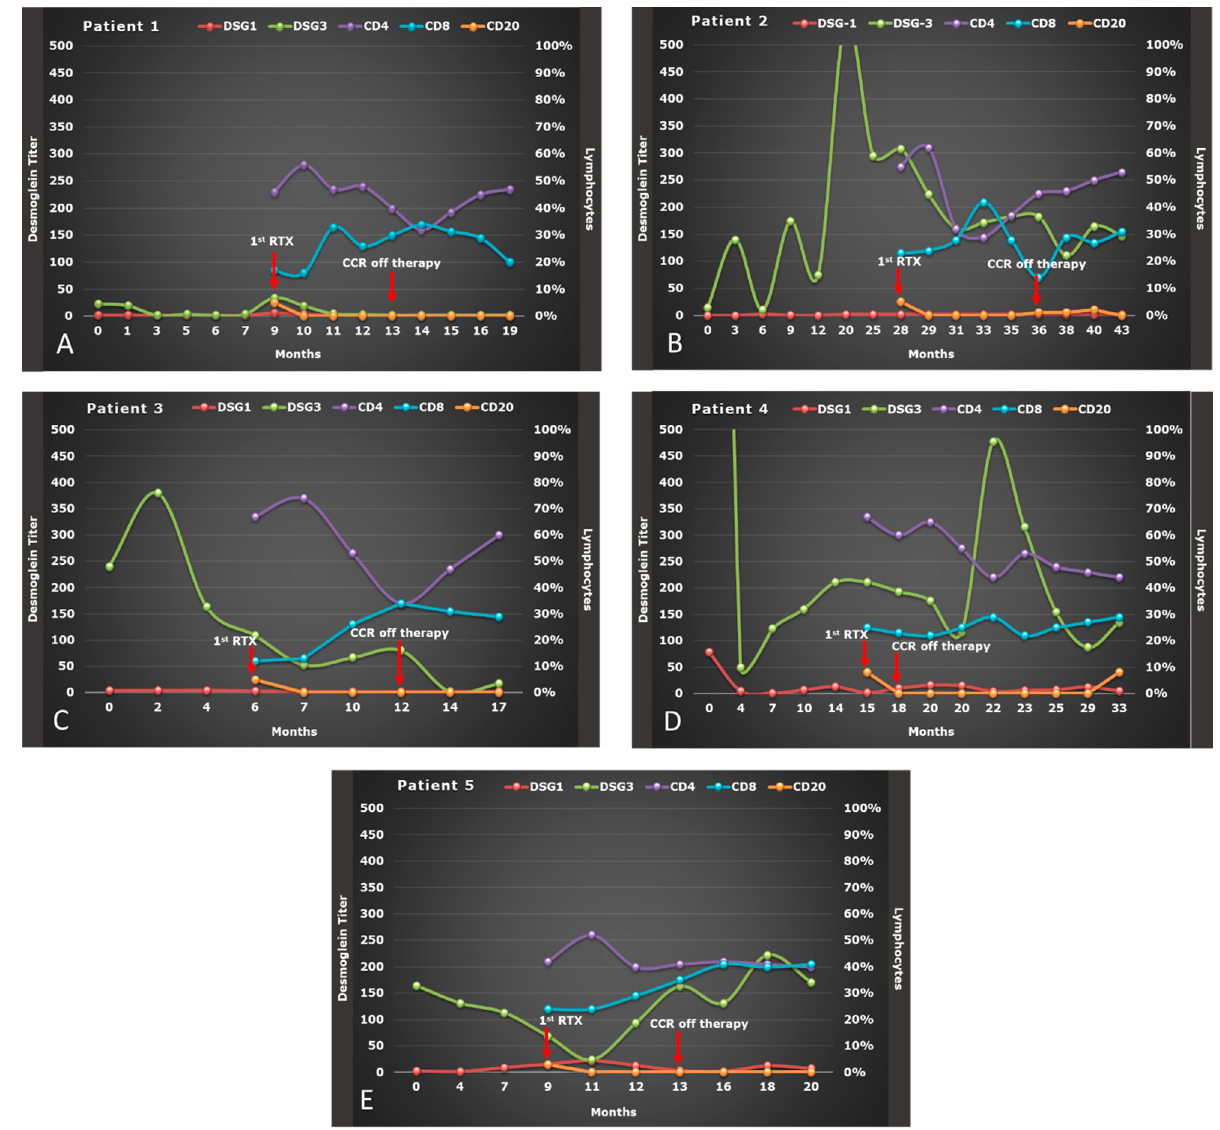
Figure 1. ( A–E ) Evolution of anti-desmoglein (DSG 1 and 3) antibody titer, of CD4, CD8, and CD20, and PDAI-oral mucosa of OPV patients (#1–5) during therapy with RTX.